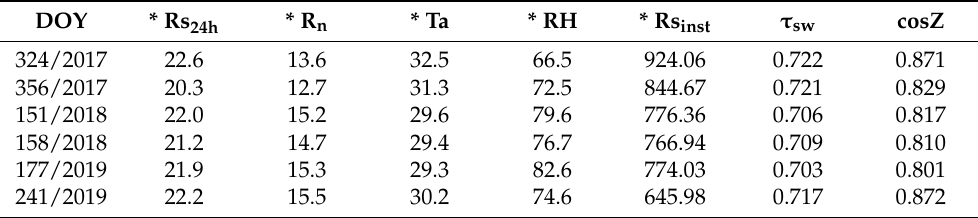
Table 2. Rs 24h : total daily global solar radiation (MJ m − 2 ); R n : total daily radiation balance (MJ m − 2 ); Ta: air temperature at the moment of the satellite passage ( ◦ C); RH: relative humidity at the moment of the satellite passage (%); Rs inst : instantaneous global radiation at the moment of the satellite passage (W m − 2 ); τ sw : atmospheric transmissivity at the moment of the satellite passage; cosZ: cosine of the solar zenith angle at the moment of the satellite passage.